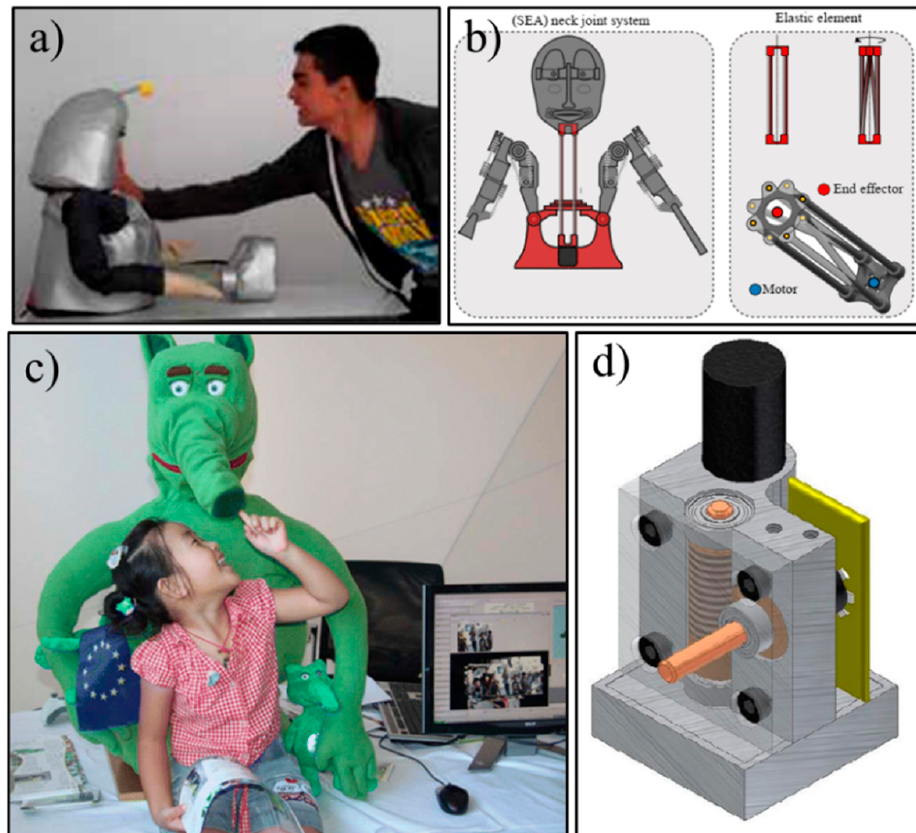
Figure 1. ( a ) The CASTOR robot’s soft outer shell has the ability to absorb impact, courtesy of Casas-Bocanegra et al. [21], ( b ) the SEA neck joint and the integrated element connecting the head and the body in the CASTOR robot, courtesy of Casas-Bocanegra et al. [21], ( c ) the Probo robot with a removable soft jacket and expressive trunk, courtesy of Saldien et al [38], and ( d ) the schematic of the NBDS actuation system for Probo showing the worm gear design, courtesy of Saldien et al [32]. All images are courtesy of open access articles. Figure 1c. To achieve safe and soft movements, two compliant actuators (the compliant Bowden cable-driven actuator (CBCDA) and the non-back drivable servo (NBDS)) were utilized in the robot [29]. The CBCDA is a passive compliant servomotor system that transmits motions over long distances by using cables (the Bowden cable). The main actuators (servomotors) in the CBCDAs are placed in the body of the robot while the cables are connected to several motional expression components, such as the eyes, eyelids, and the eyebrows, in the facial region. As the cable itself is highly flexible and elastic, compliance of the CBCDA can be achieved by adjusting the tension of the Bowden cable during the winding process to the servomotor. Both the flexible nature of the cable and adjustable tension feature enable the CBCDA to act as damping features to absorb a certain amount of force during physical interaction, such as punching or pushing from the users. On the other hand, the NBDS uses a set of worm gear and worm wheel design, as shown in Figure 1d, to ensure the transmission from the servo is non-reversible. This non-reversibility ensures that the output (physical force applied by children interacting with the robot) will not be transmitted back to the motor or the robot.